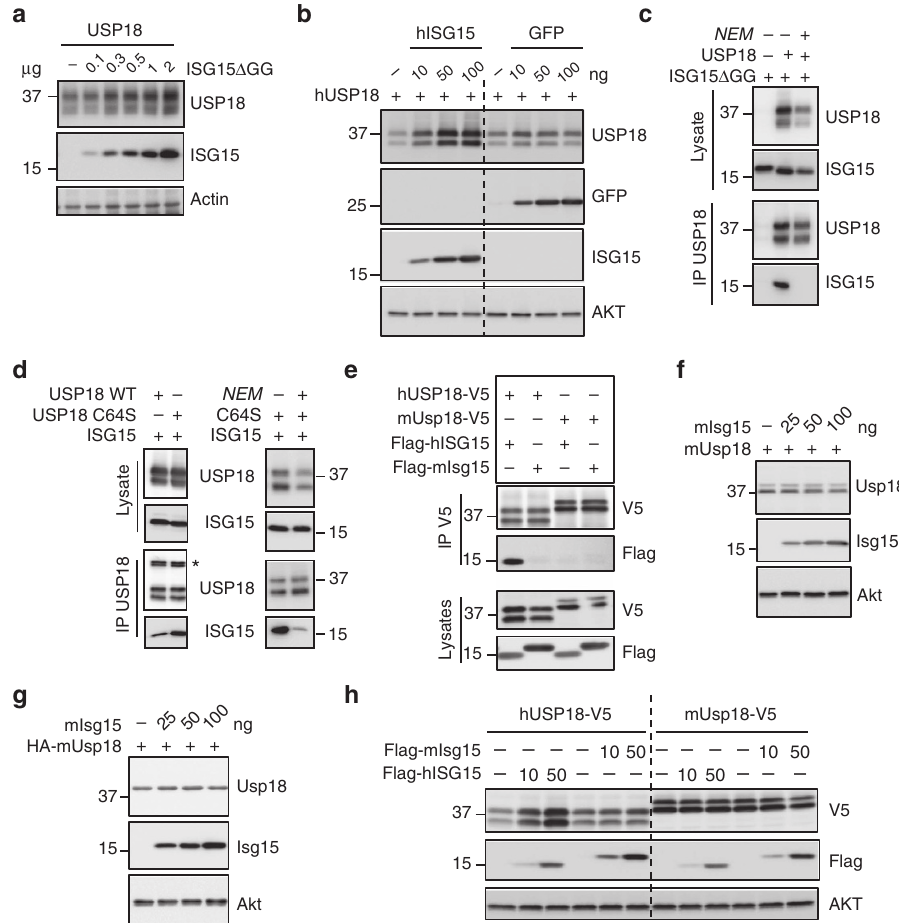
Figure 5 | Murine free Isg15 does not interact stably with Usp18. ( a ) HEK293T cells were transfected with a human USP18 expression vector (0.5 m g) alone or with increasing amounts of the human Flag-ISG15 D GG construct. 48h post transfection, cell lysates were analysed by western blot with antibodies against USP18 and Flag. ( b ) Cells were transfected with human USP18 (0.5 m g) alone or with increasing amounts of human ISG15 or GFP expression vectors. 48h later lysates were analysed with the indicated antibodies. ( c ) Cells were transfected with human Flag-ISG15 D GG (3 m g) alone or with human USP18, as indicated (1.5 m g). NEM (10mM) was added to the lysis buffer (lane 3). Lysates were subjected to IP with USP18 antibodies. Lysates and co-IP eluates were analysed with antibodies against USP18 and Flag. ( d ) Left panel: cells were transfected with human Flag-ISG15 (1.5 m g), and either human USP18 WT or USP18 C64S (1.5 m g). 48h later, lysates were subjected to anti-USP18 IP. Lysates and co-IP eluates were analysed with antibodies against USP18 and Flag. Right panel: cells were cotransfected with Flag-ISG15 (1.5 m g) and USP18 C64S (1.5 m g). NEM (10mM) was added to the lysis buffer (lane 3). Lysates were subjected to anti-USP18 IP. Lysates and co-IP eluates were analysed with antibodies to USP18 and Flag. ( e ) Cells were cotransfected with human or murine USP18-V5 and human or murine Flag-ISG15. 48h later, lysates were subjected to co-IP with anti-V5 antibodies. Co-IP eluates (top panels) and total lysates (bottom panels) were analysed with the indicated antibodies. ( f ) Cells were transfected with untagged murine Usp18 (0.5 m g) alone or with increasing amounts of murine Flag-Isg15. Lysates were analysed with antibodies to murine Usp18, Flag and Akt. ( g ) As in f , except that HA-tagged alone or with the indicated amount of human Flag-ISG15 or murine Flag-Isg15. 48h later, cell lysates were analysed by western